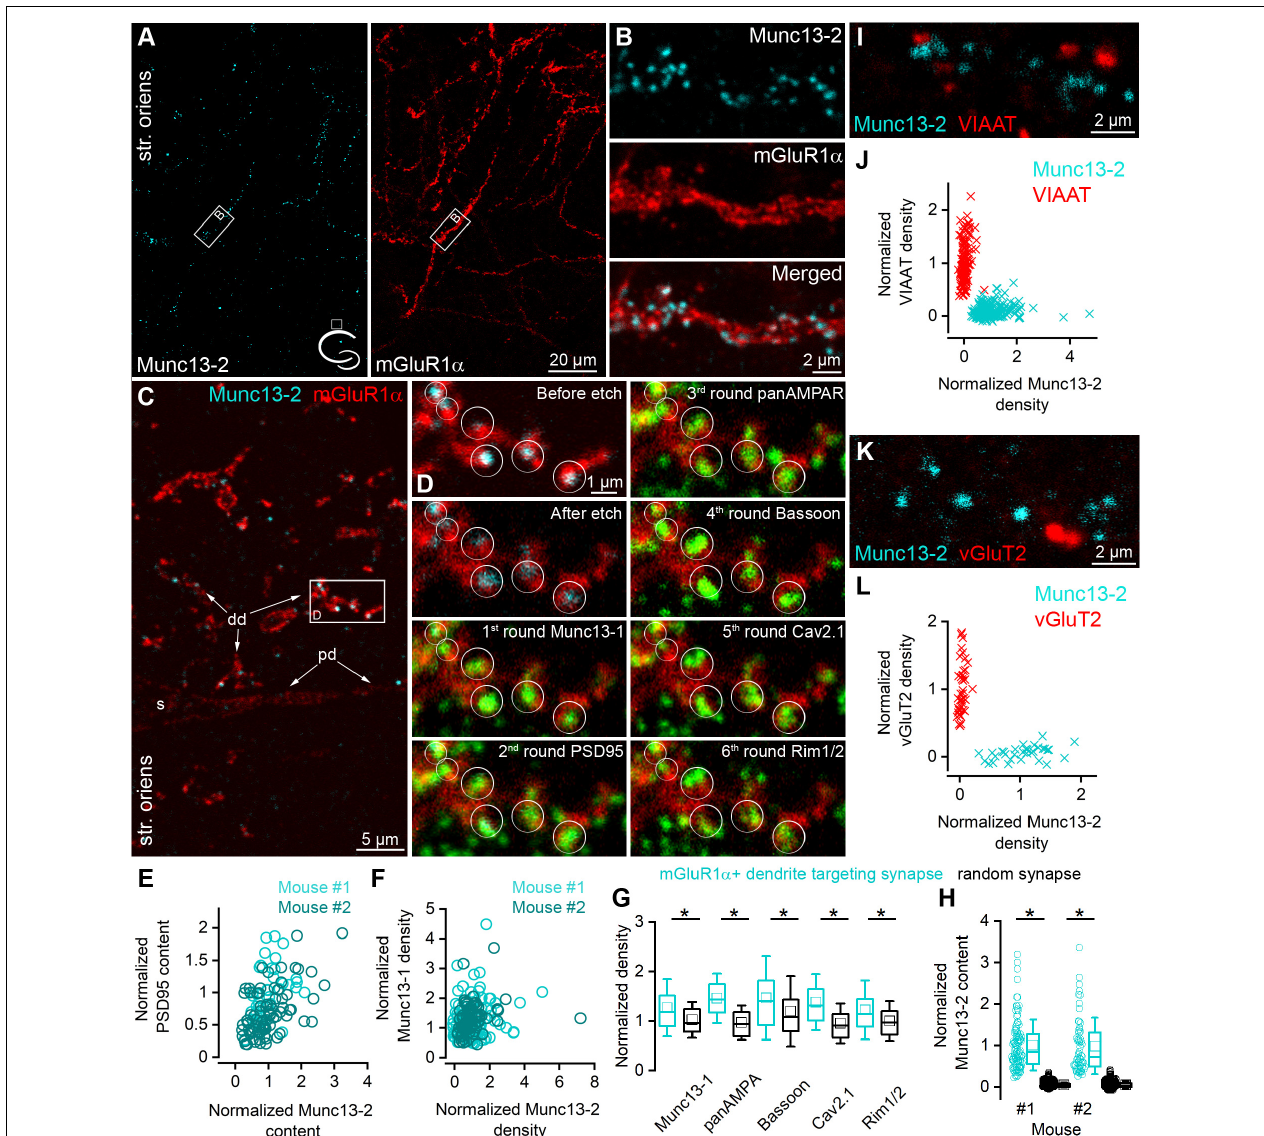
FIGURE 1 | Munc13-2 immunolabeling is enriched on mGluR1 α immunopositive dendrites. (A) Double immunolabeling for Munc13-2 (left, cyan) and mGluR1 α (right, red) in the dorsal hippocampal CA1 region of the mouse (cartoon indicates the location of the region) shows similar distribution in the stratum oriens. Maximum intensity projection of six confocal images separated by 1 µ m. (B) A dendritic segment of an mGluR1 α immunopositive IN (white boxes on A ) is shown at a higher magnification, which is decorated by Munc13-2 immunopositive puncta. Maximum intensity projection of three confocal images separated by 1 µ m. (C) 500 nm thick epoxy resin embedded section with preembedding immunolabeling for Munc13-2 (cyan) and mGluR1 α (red) shows that Munc13-2 immunopositive puncta preferentially located on the small diameter of mGluR1 α + (distal) dendrites (dd), and mainly avoid the soma (s) and a proximal dendrite (pd) in the hippocampus of the mouse. Boxed area is enlarged on panel (D) . (D) Multiplexed postembedding immunolabeling carried out on the section shown in panel (G) . Munc13-2 immunopositive puncta marked by circles (representing ROIs for quantification) along the mGluR1 α immunolabeled dendrite are immunopositive for Munc13-1, PSD95, AMPA receptors, Bassoon, Cav2.1,and Rim1/2 (all pseudo colored to green). Note that the intensity of Munc13-2 immunolabeling varies substantially. Alignment of sections after each round was based on mGluR1 α immunolabeling (red). Numbers represent the labeling rounds during the multiplexed labeling. (E) All of the Munc13-2 immunopositive puncta contain PSD95 immunosignal. Their amount shows positive correlations (Spearman correlation r = 0.48 and 0.55, n = 40 in mouse #1 and n = 80 in mouse #2). (F) Correlations between the density of the Munc13-2 and Munc13-1 in individual AZs (each data point represents an AZ, n = 114 in mouse #1 and n = 80 in mouse #2; Spearman correlation r = 0.16 and 0.34). (G) mGluR1 α IN targeting synapses have significantly larger (*) Munc13-1, AMPA receptors, Bassoon, Cav2.1 and Rim1/2 densities than those found in randomly selected glutamatergic synapses in the str. oriens ( p = 1.5 × 10 − 5 , 5.5 × 10 − 24 , 1.5 × 10 − 4 , 6.6 × 10 − 16 , 1.3 × 10 − 5 , respectively, MW- U -test). Box plots represent median and 25/75 percentiles, square represent the mean value, whiskers represent SD. All immunolabelings were normalized to PSD95 intensity on panels (F,G) . (H) The Munc13-2 content of randomly selected synapses is only 4 ± 7% and 4 ± 10% (in two mice; p = 0 for both MW- U -test) of that of synapses on mGluR1 α + dendrites. (I–L) Munc13-2 immunolabeling (cyan) does not colocalize either with vesicular inhibitory amino acid transporter (VIAAT, red) ( I,J , n = 152 Munc13-2 and 222 VIAAT positive profiles in 2 mice) or with vesicular glutamate transporter-2 (vGluT2, red) (K,L) , n = 43 Munc13-2 and 33 vGluT2 positive profiles in 1 mouse). Single confocal images (I,K) . str. oriens, stratum oriens.